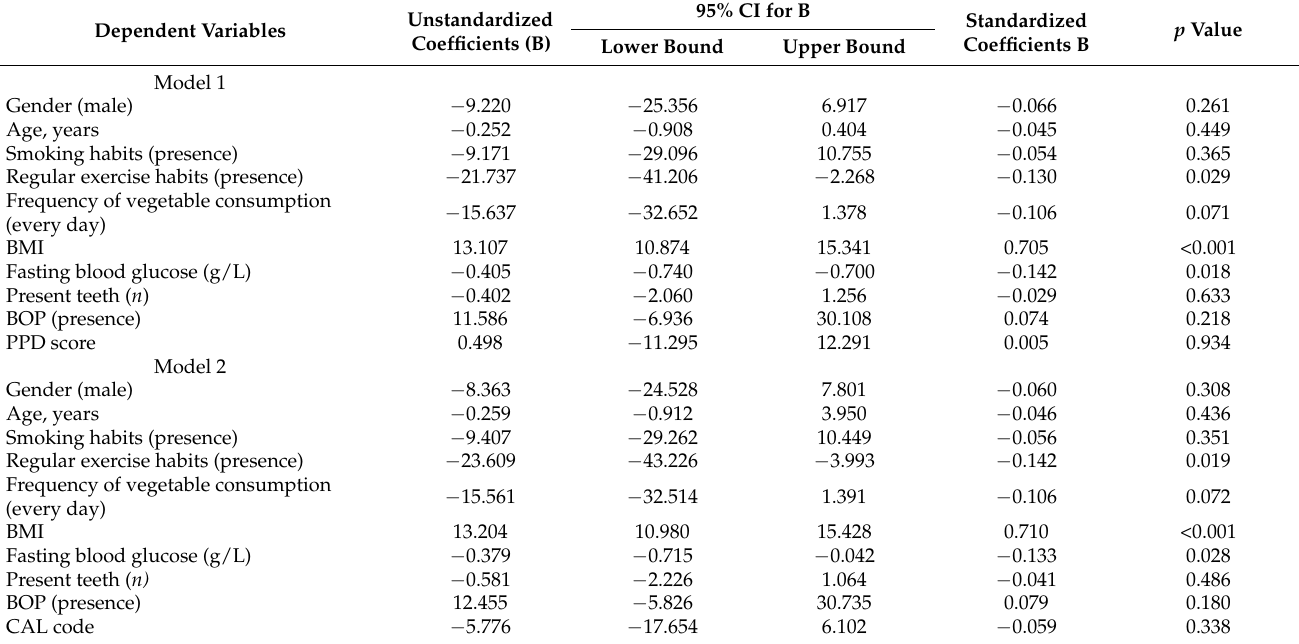
Table 5. Factors associated with SFA in the study population by multiple regression